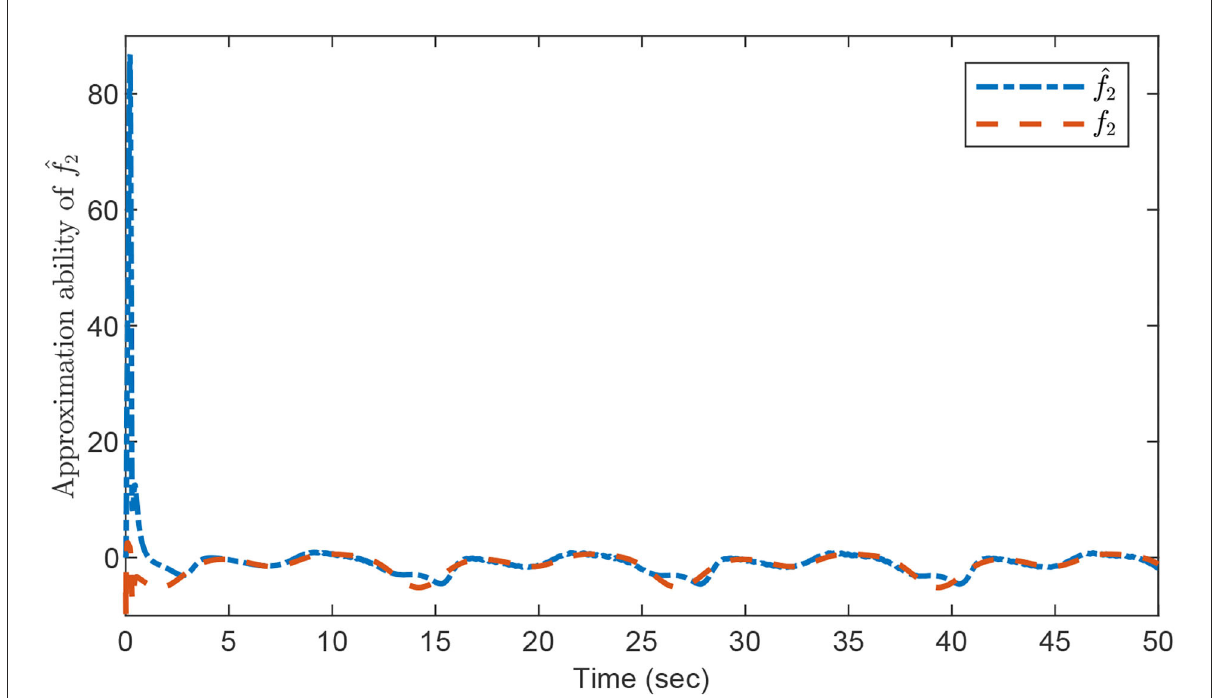
FIGURE4 Approximation ability of ˆ f 2 by using composite learning adaptive